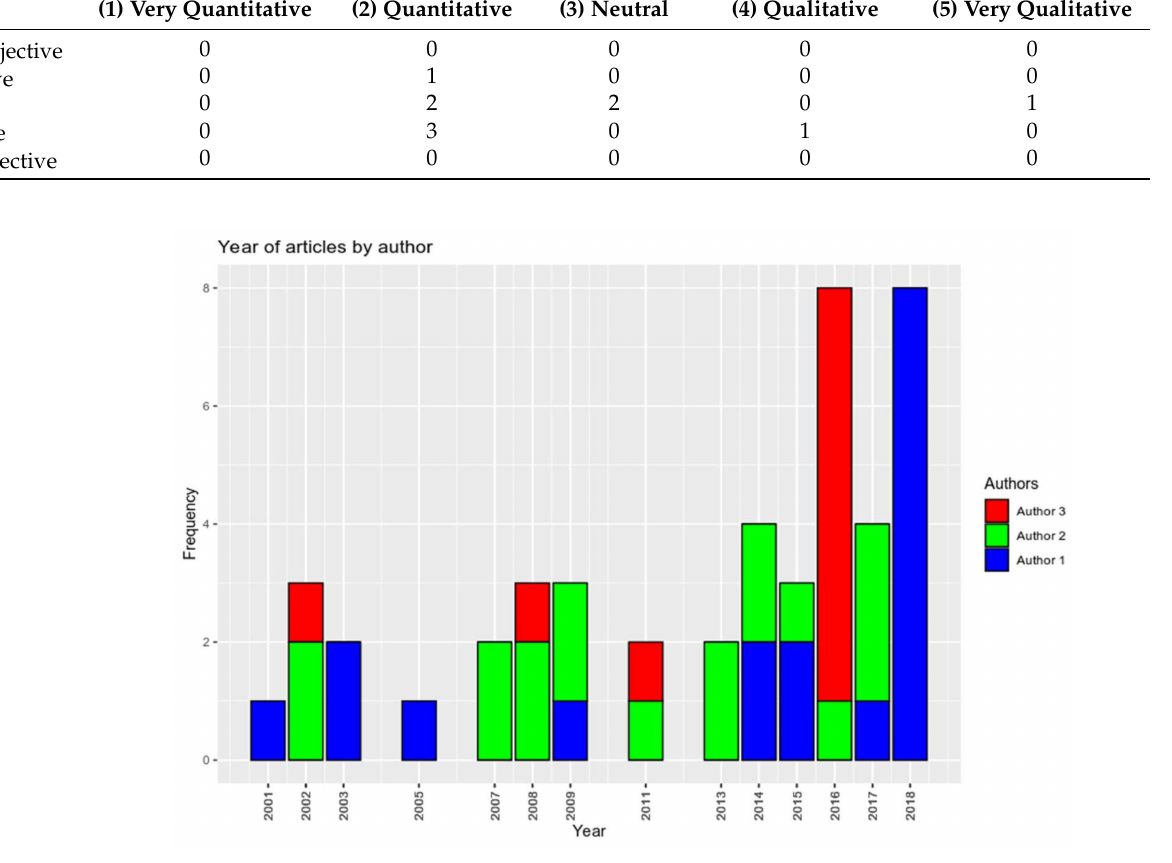
Figure 2. Year of source by